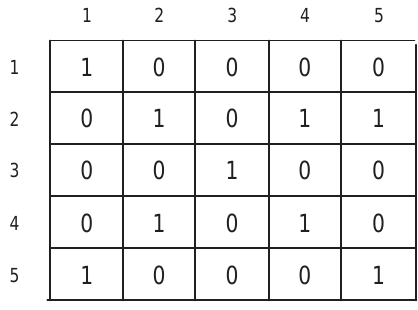
Figure 2. Generated bitmap matrix corresponding to Figure 1.